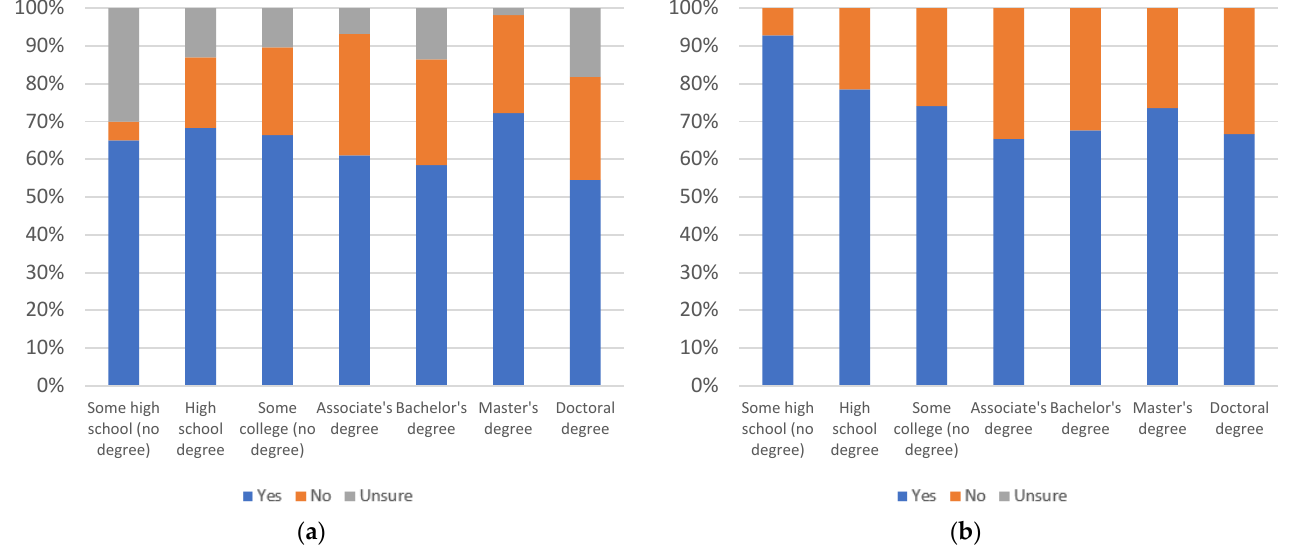
Figure 37. Label helpfulness, by age group: ( a ) with uncertain respondents (left) and ( b ) without uncertain respondents (right).